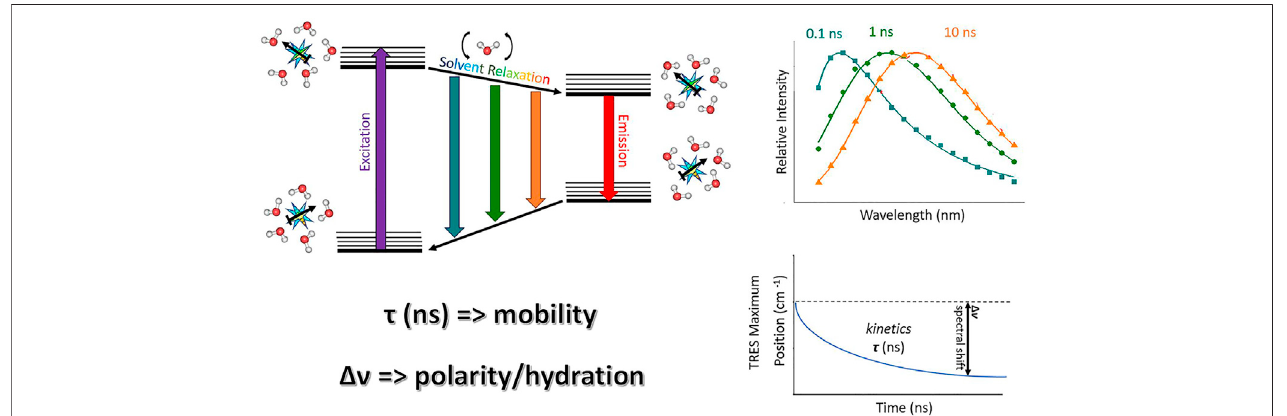
FIGURE1| AschematicdrawingillustratingTDFSmethod:Ontheleft,asimpli fi edJablonskidiagramisdepicted.A fl uorescenceproberepresentedbyalightblue star bearing certain dipole moment (black arrow) is solvated by water molecules. These are oriented in the energetically lowest conformation in the ground state. Upon the excitation, a dipole of the dye changes rapidly, organization of the solvation shell thus becomes energetically unfavorable. Consequently, the solvent molecules start to reorient which decreases the energy of the system. This continuous decrease can be accessed by recording TRES which shows red-shift in time (upper right fi gure). The TRES maxima are then analyzed yielding overall dynamic Stokes shift Δν and characteristic relaxation time τ (lower right fi gure). Δν and τ re fl ect the extent of energy relaxation caused by hydration and mobility of the hydrated lipid segments in the probe microenvironment, respectively.